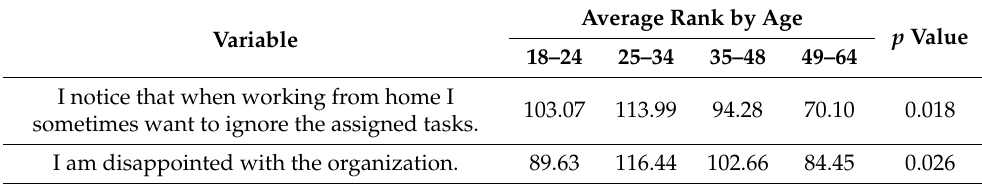
Table 10. Occupational cynicism and commitment to work by